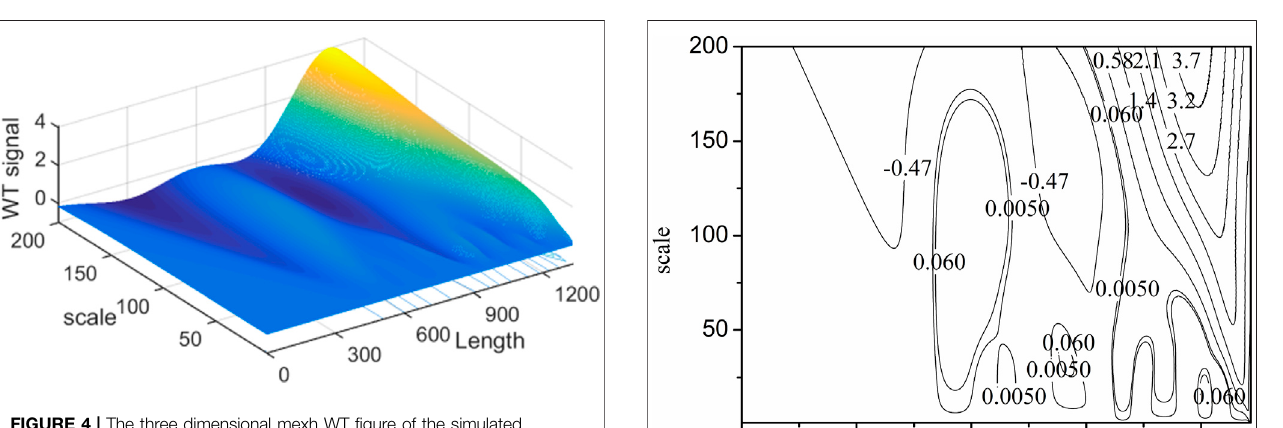
FIGURE 4 | The three dimensional mexh WT fi gure of the simulated